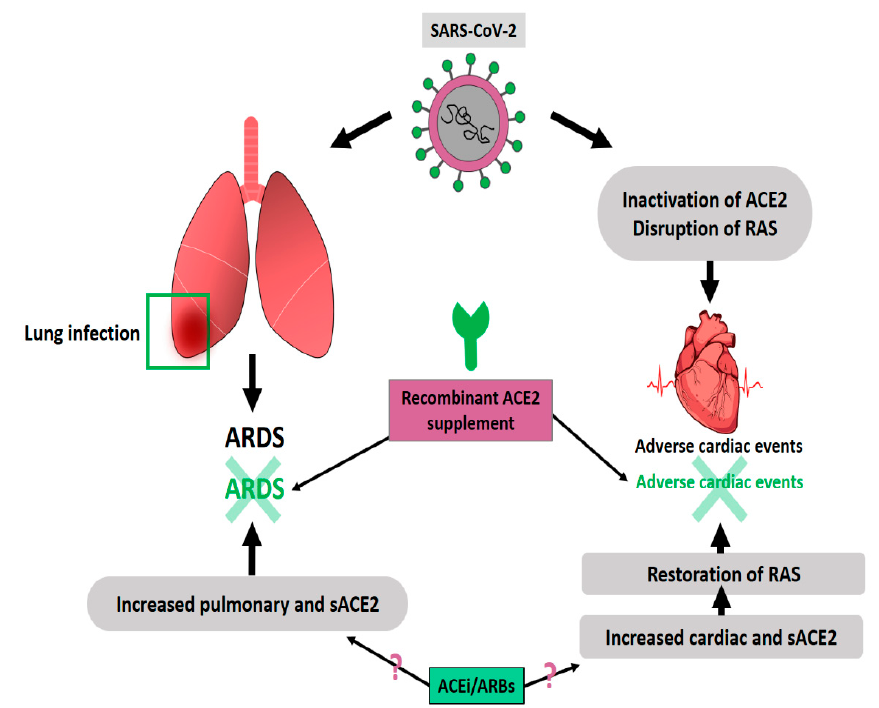
Figure 7. Potential approaches against ARDS and adverse cardiac events relevant to SARS-CoV-2 infection.